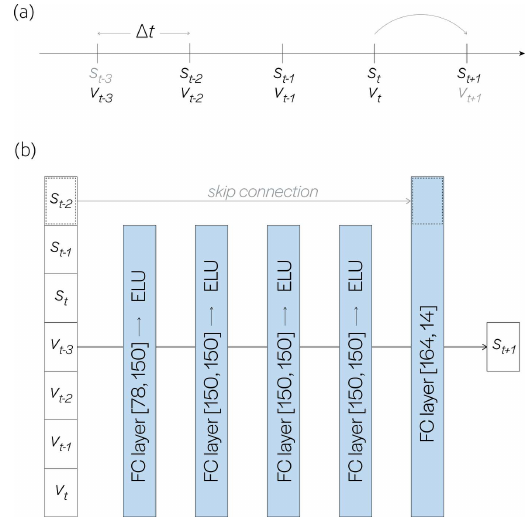
Figure 1 Discretization and neural network architecture. ( a ) Our discrete-time model aims to predict the shape of the mirror at a time (cid:2) t in the future ( s t +1 ) using a finite history of mirror shapes and voltages input to actuators. Note that s t (cid:2) 3 and v t +1 are not used in the prediction of s t +1 . ( b ) Our learned system dynamics model consists of five fully connected (FC) layers ([input dimension, output dimension]) followed by exponen- tial linear unit (ELU) activation functions. Additionally, a skip connection was introduced which greatly improved its ability to predict when the mirror was at or close to